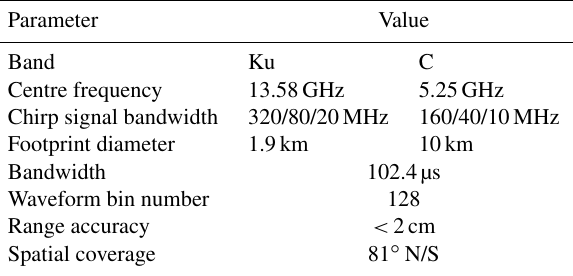
Table 1. HY-2B radar altimeter main parameters.